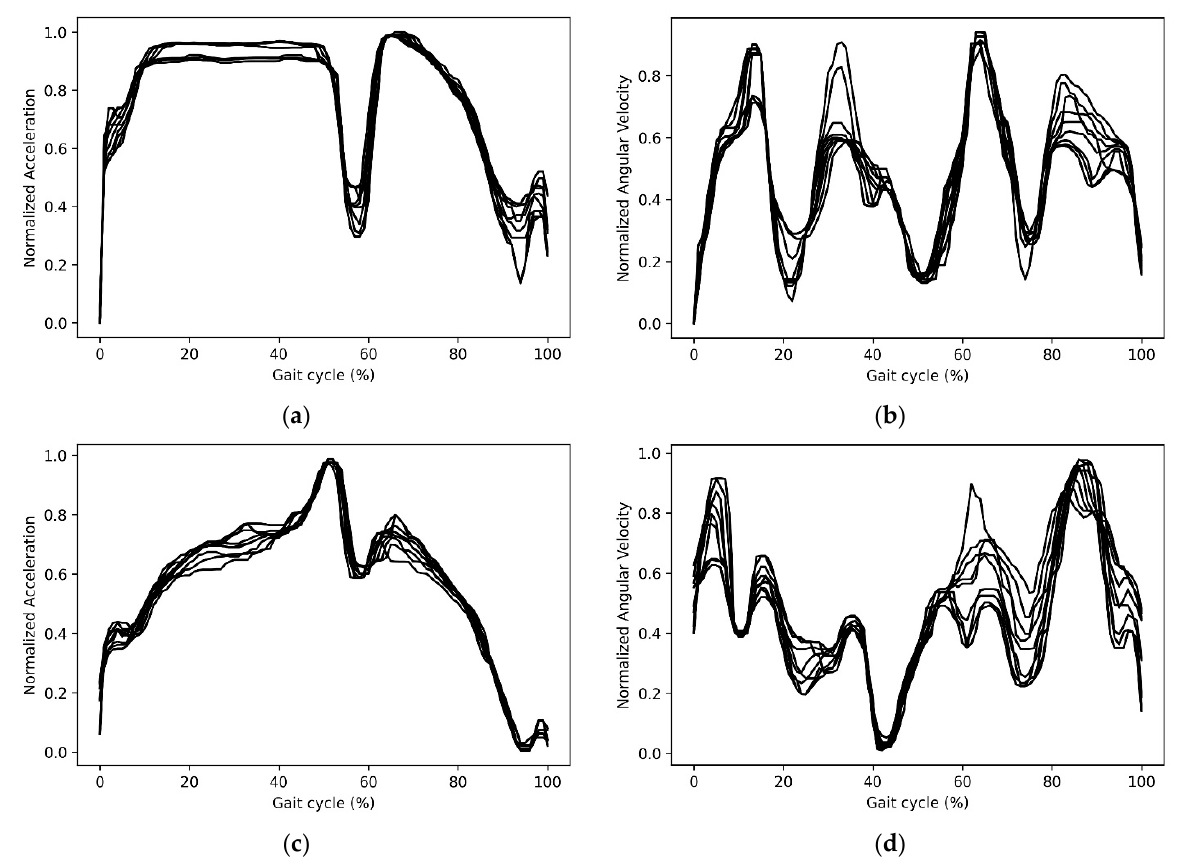
Figure 2. A sample of IMU data. ( a ) Foot x-axis acceleration ( b ) Trunk y-axis angular velocity ( c ) Shank z-axis Acceleration ( d ) Thigh x-axis angular velocity.